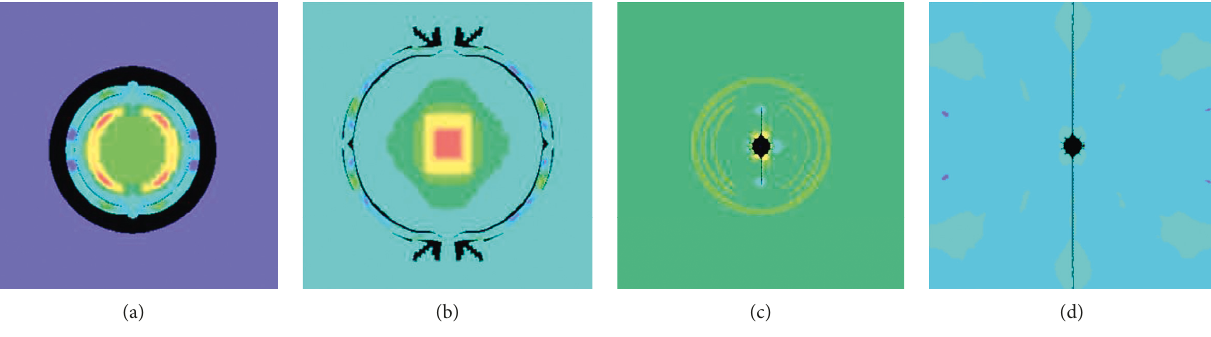
Figure 5: The initiation and propagation of the directional crack in the granite: (a) t � 1.89; (b) t � 6; (c) t � 60; (d) t � 300.